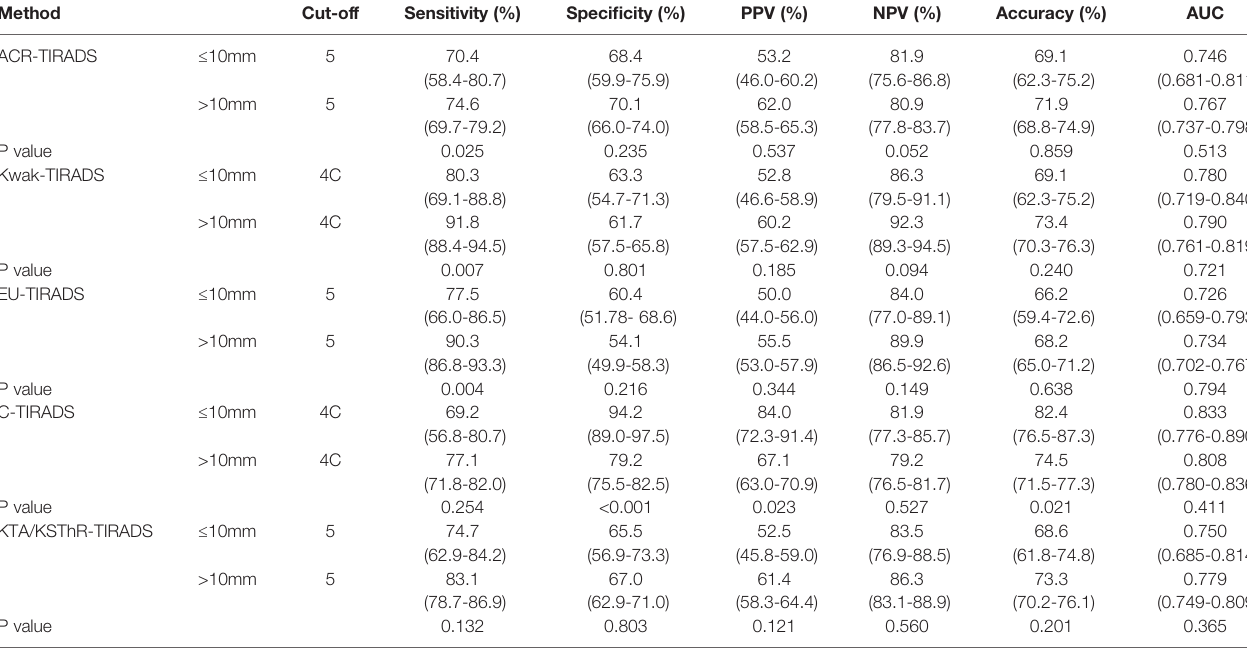
TABLE 4 | Diagnostic performance of different sizes of 5 guidelines.